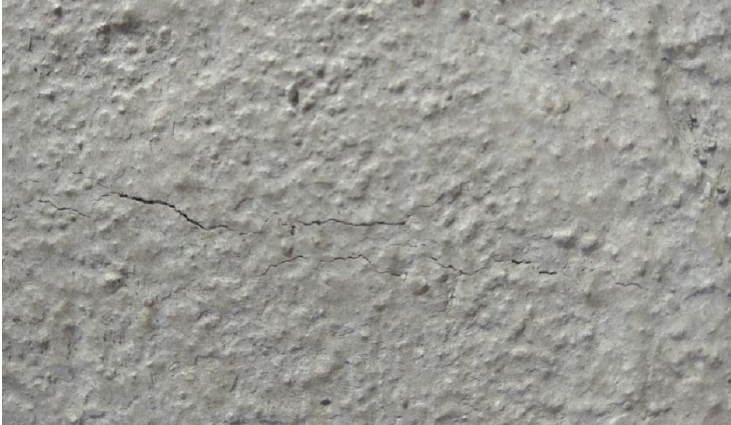
Figure 1. Early-age transverse cracks that occurred in a newly cast reinforced concrete column; these cracks occurred within three days after placing of concrete; the column was cured by wet